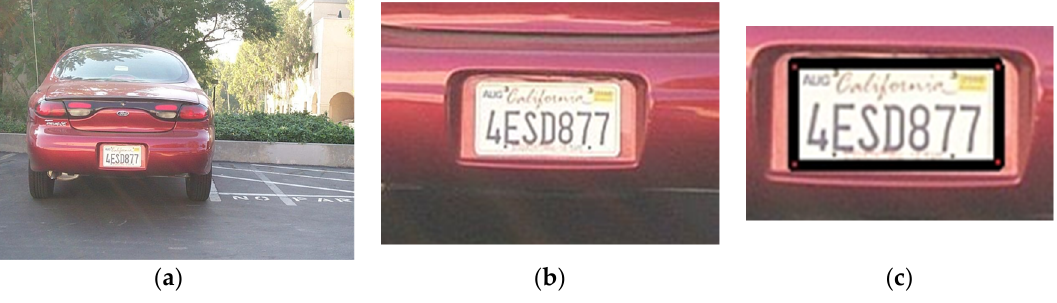
Figure 2. Potential number detection and corners identification: ( a ) original picture with a car; ( b ) the original coordinates are increased and the number is cut out; ( c ) the four corners of the number are found.